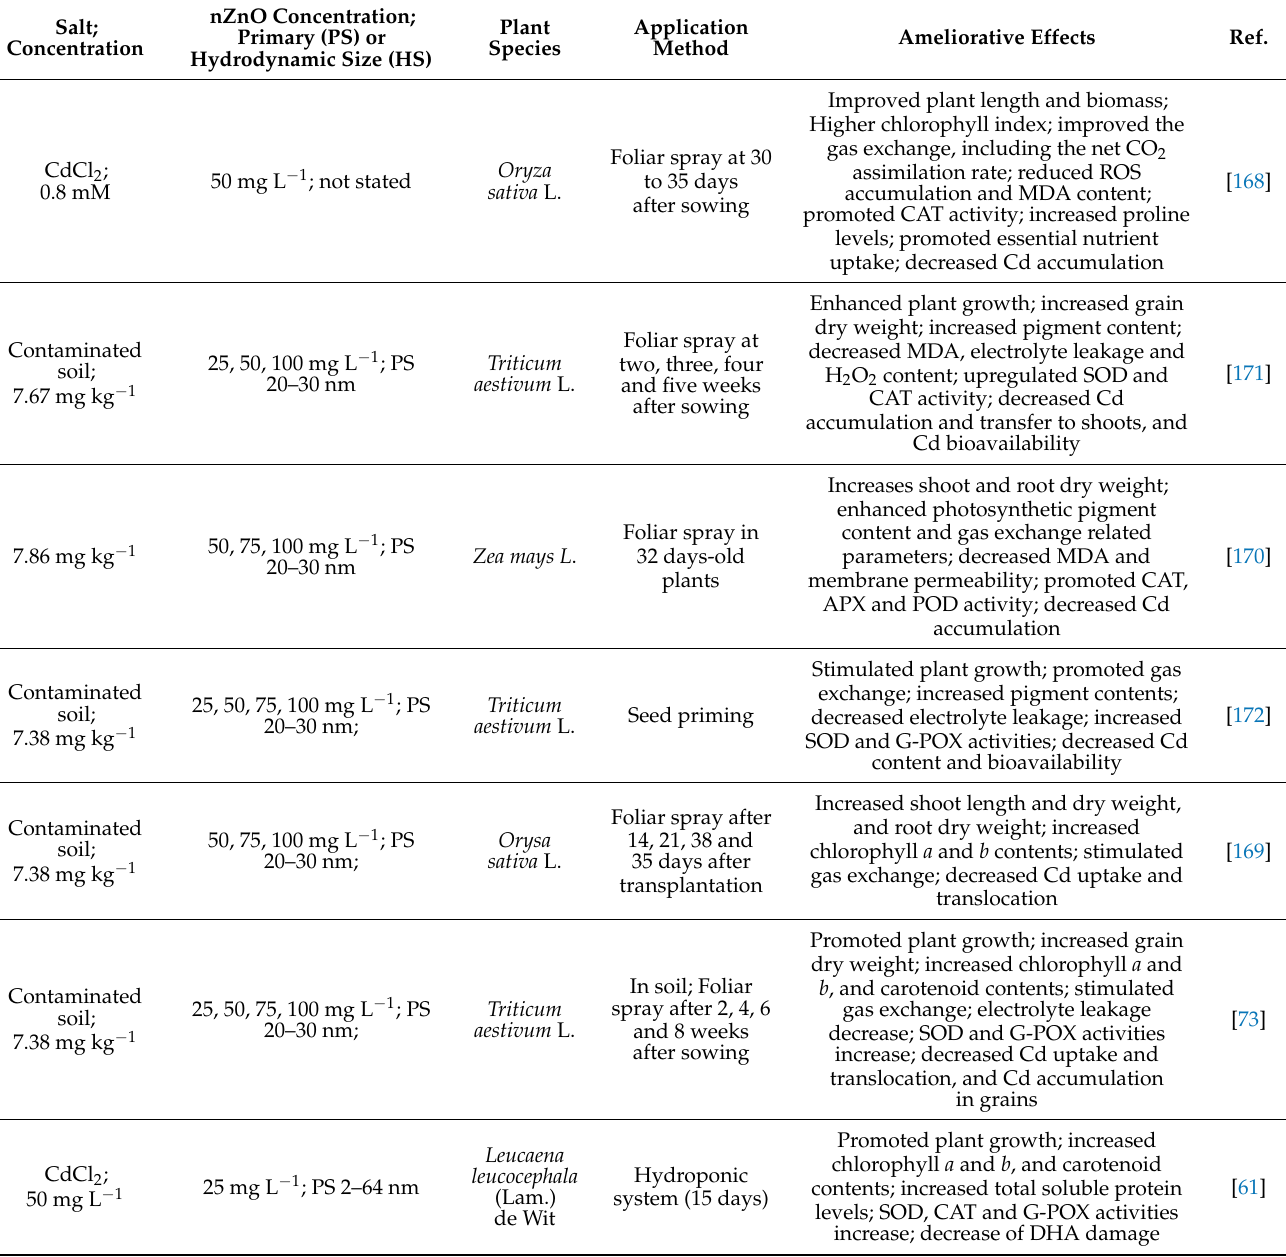
Table 7. Ameliorative effects of nZnO application against the phytotoxicity of Cadmium